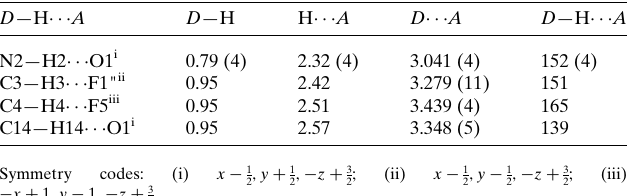
Table 1 Hydrogen-bond geometry (A˚ , (cid:6) ).